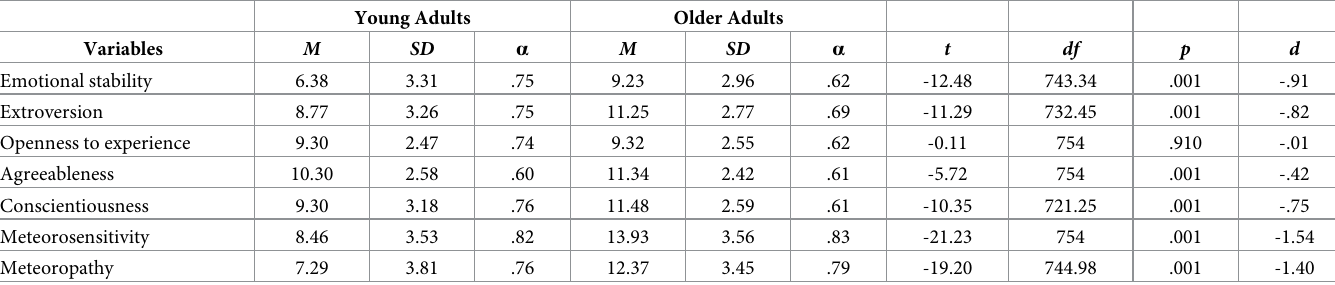
Table 3. Values of analyzed variables in the young and older adult groups with the values of student’s independent sample t-test.